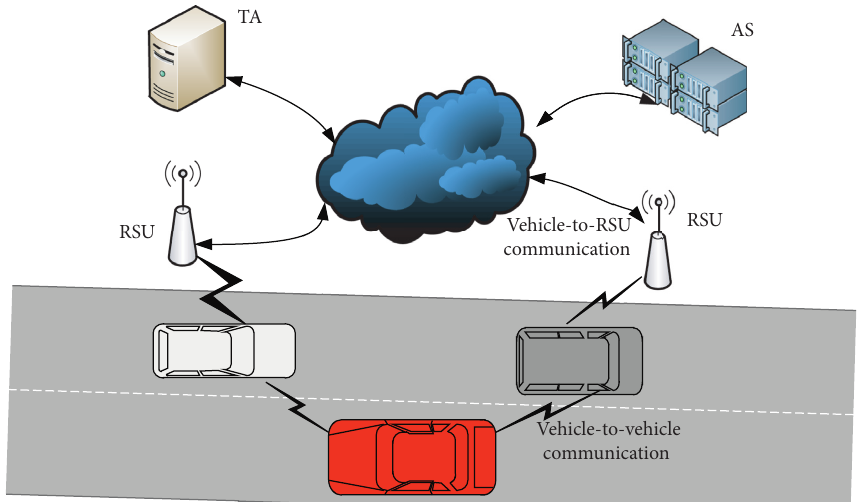
Figure 1: VANET network